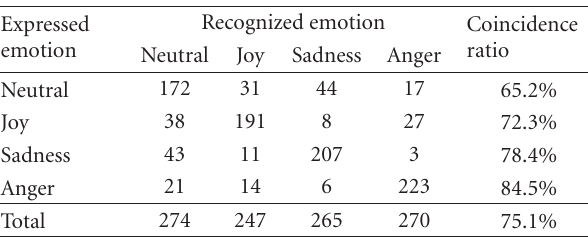
Table 6: Coincidence ratios of